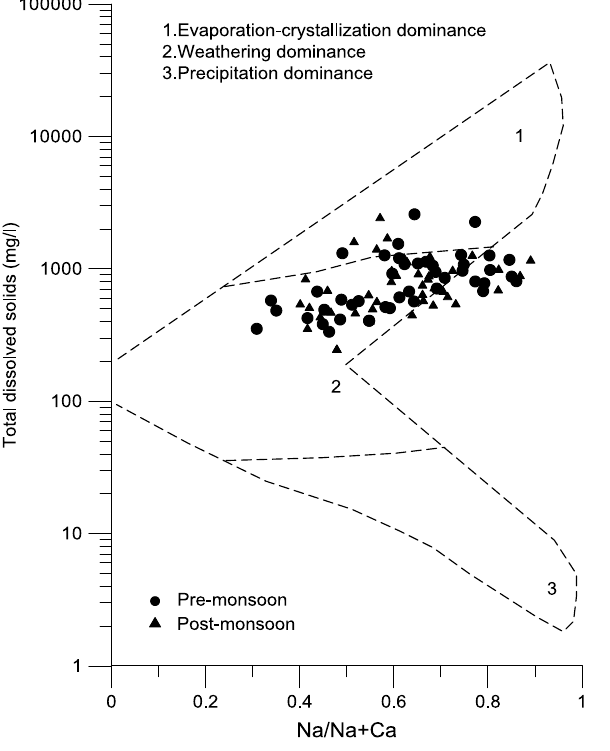
Fig. 16 Gibbs diagram shows that in both the pre-monsoon and post- monsoon seasons water–rock/soil interaction is responsible for the chemical composition of the groundwater in the study area